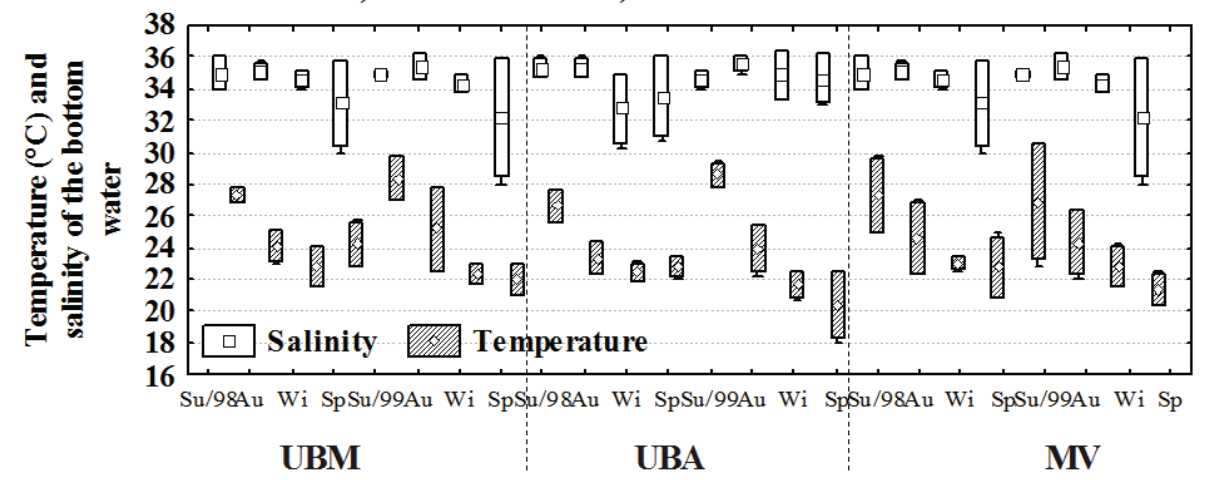
Figure 2. Mean values (minimum and maximum) of salinity and temperature (°C) of the bottom water from January 1998 to December 1999, in each season (Su = summer, Au = autumn, Wi = winter, Sp = spring), in the bays of Ubatumirim (UBM), Ubatuba (UBA) and Mar Virado (MV).